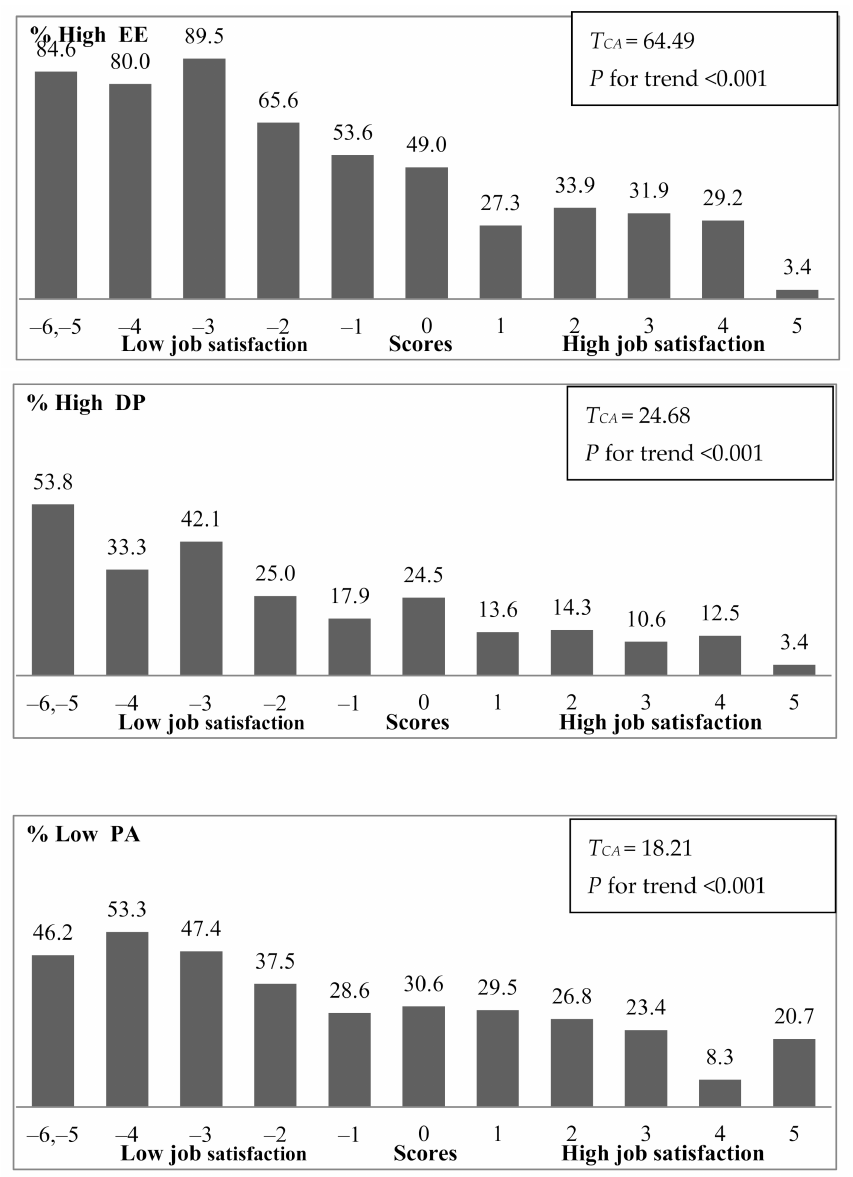
Figure 2. Percentage of high emotional exhaustion (EE), high depersonalization (DP), and low personal accomplishment, by job satisfaction scores. The respondents with a job satisfaction score of − 6 or − 5 were pooled into one group. T CA— Cochran-Armitage